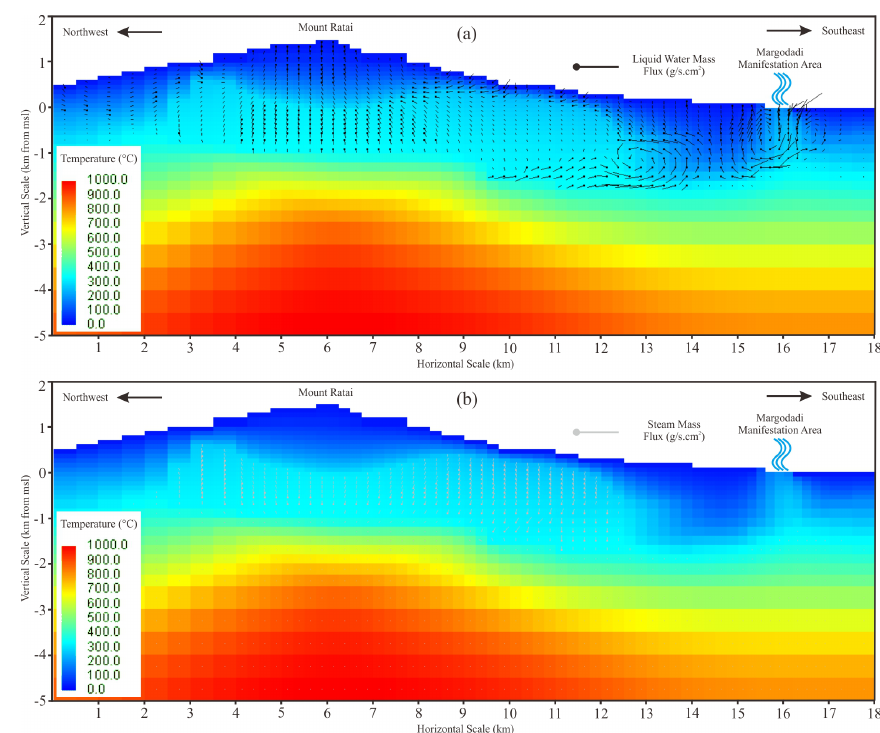
Fig. 6. Model of liquid water mass flux (a) and steam mass flux (b) of heat transfer (in ◦ C) the Way Ratai geothermal field in the 25,000th-year